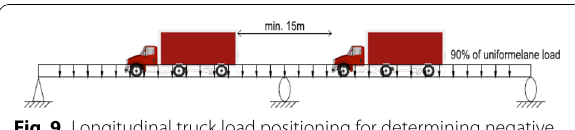
Fig. 9 Longitudinal truck load positioning for determining negative